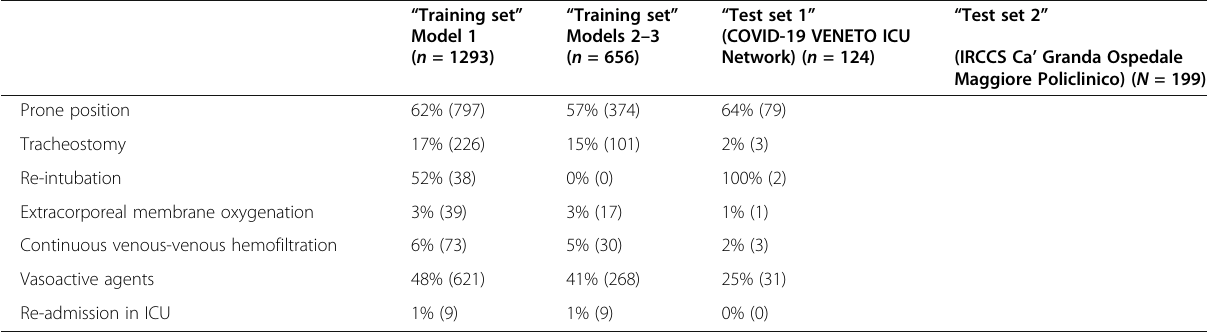
Table 1 Training and test sets characteristics (Continued)